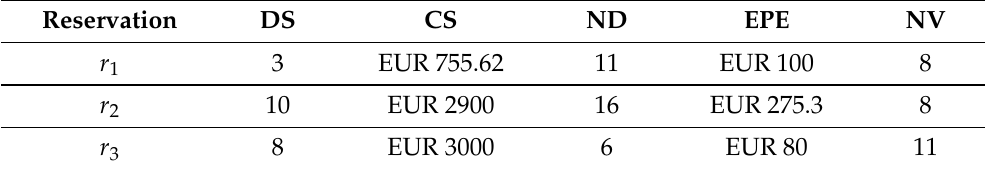
Table 4. Description of the reserves where DS, CS, ND, EPE, NV mean days of stay, cost of stay, number of diners, expenditure per reserve, and number of visits,